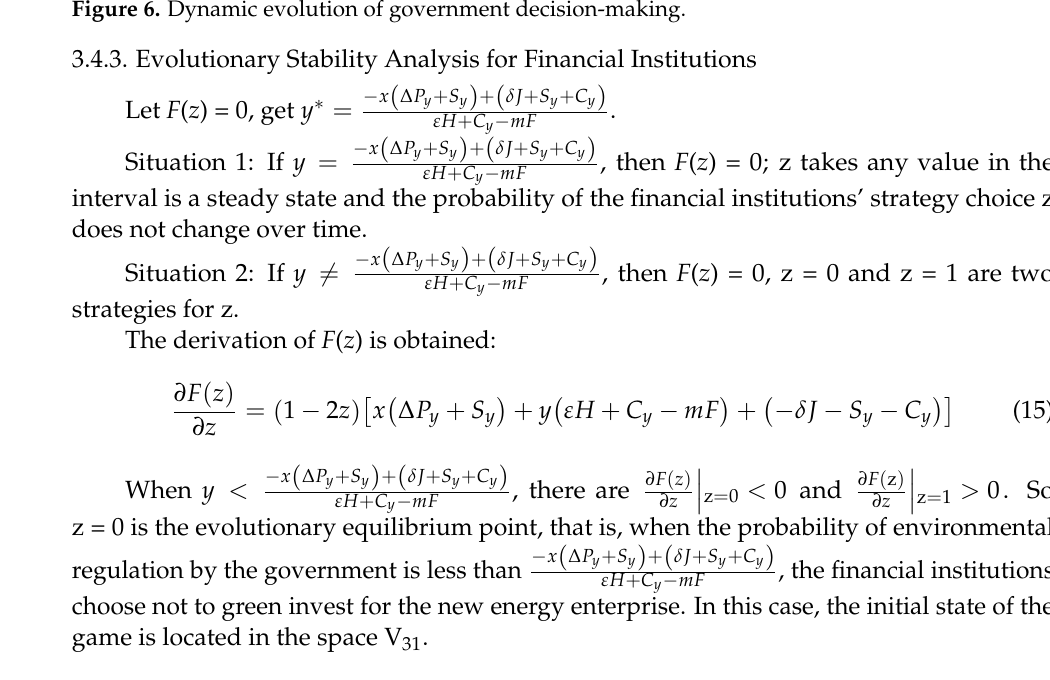
Figure 6. Dynamic evolution of government decision-making.